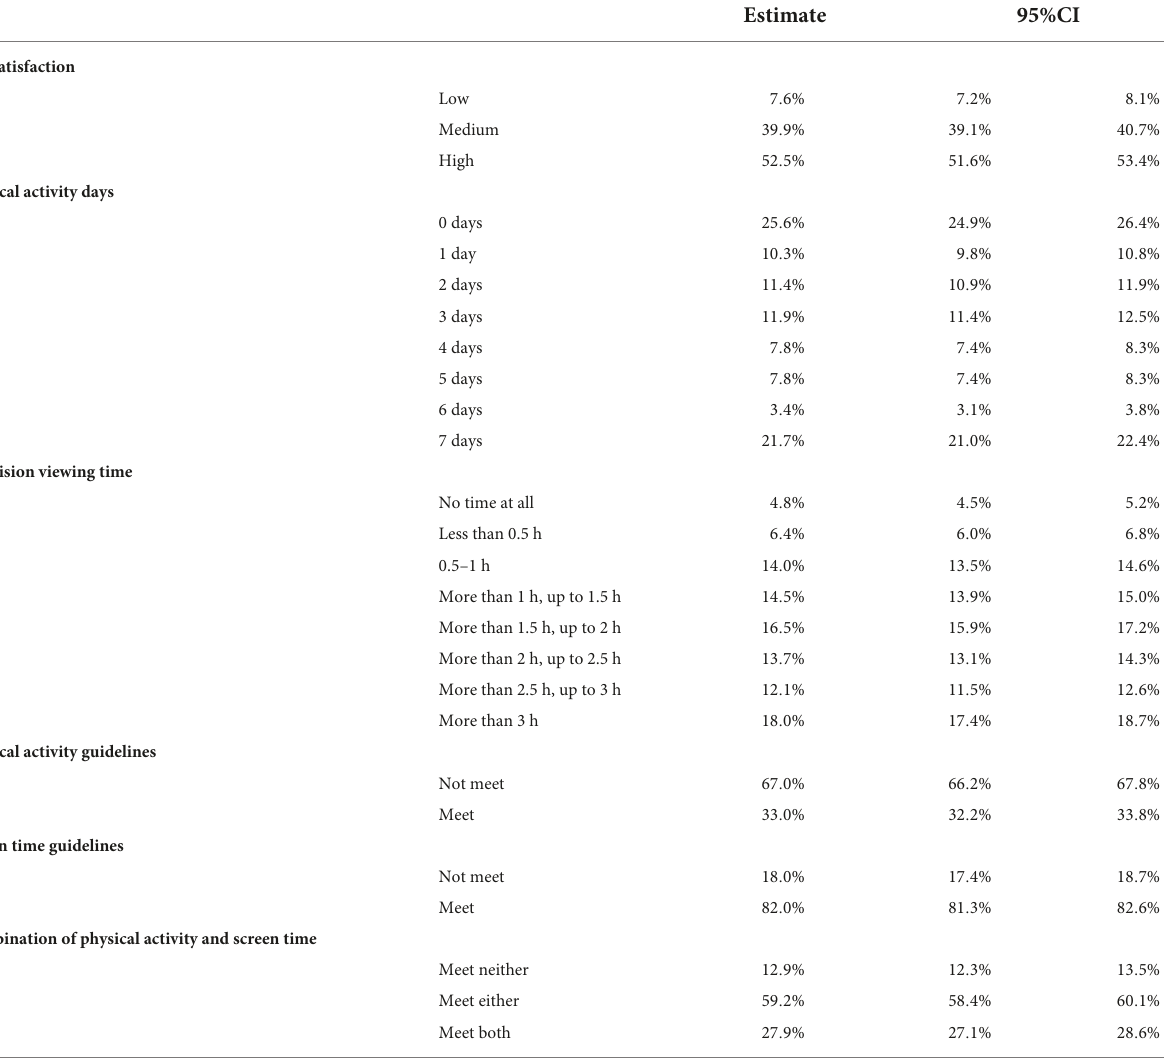
TABLE 2 Results for independents and